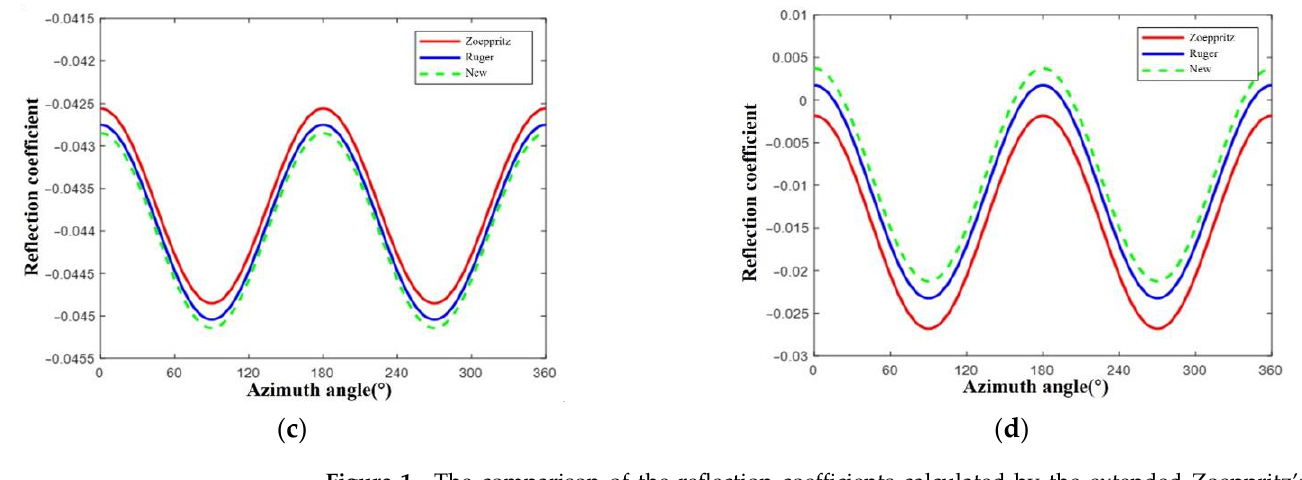
Figure 1. The comparison of the reflection coefficients calculated by the extended Zoeppritz’s equation, Rüger’s equation [14], and the derived new equation. ( a ) reflection coefficient variation with the incident angle for φ = 0 ◦ ; ( b ) reflection coefficient variation with the incident angle for φ = 90 ◦ ; ( c ) the reflection coefficient variation with azimuth for θ = 10 ◦ ; ( d ) reflection coefficient variation with azimuth for θ = 30 ◦ .